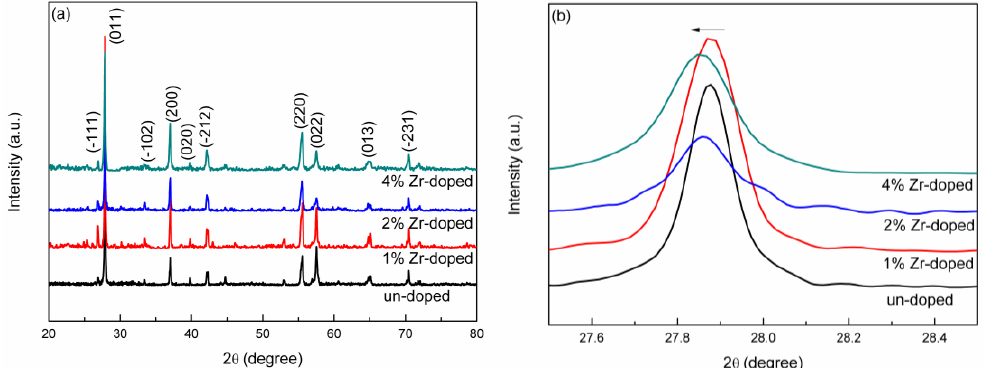
Figure 1. ( a ) X-ray diffraction (XRD) patterns and ( b ) Enlarged X-axis patterns from 27.5° to 28.5° of